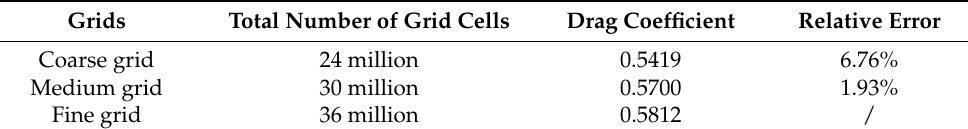
Table 3. The validation of grid independence.